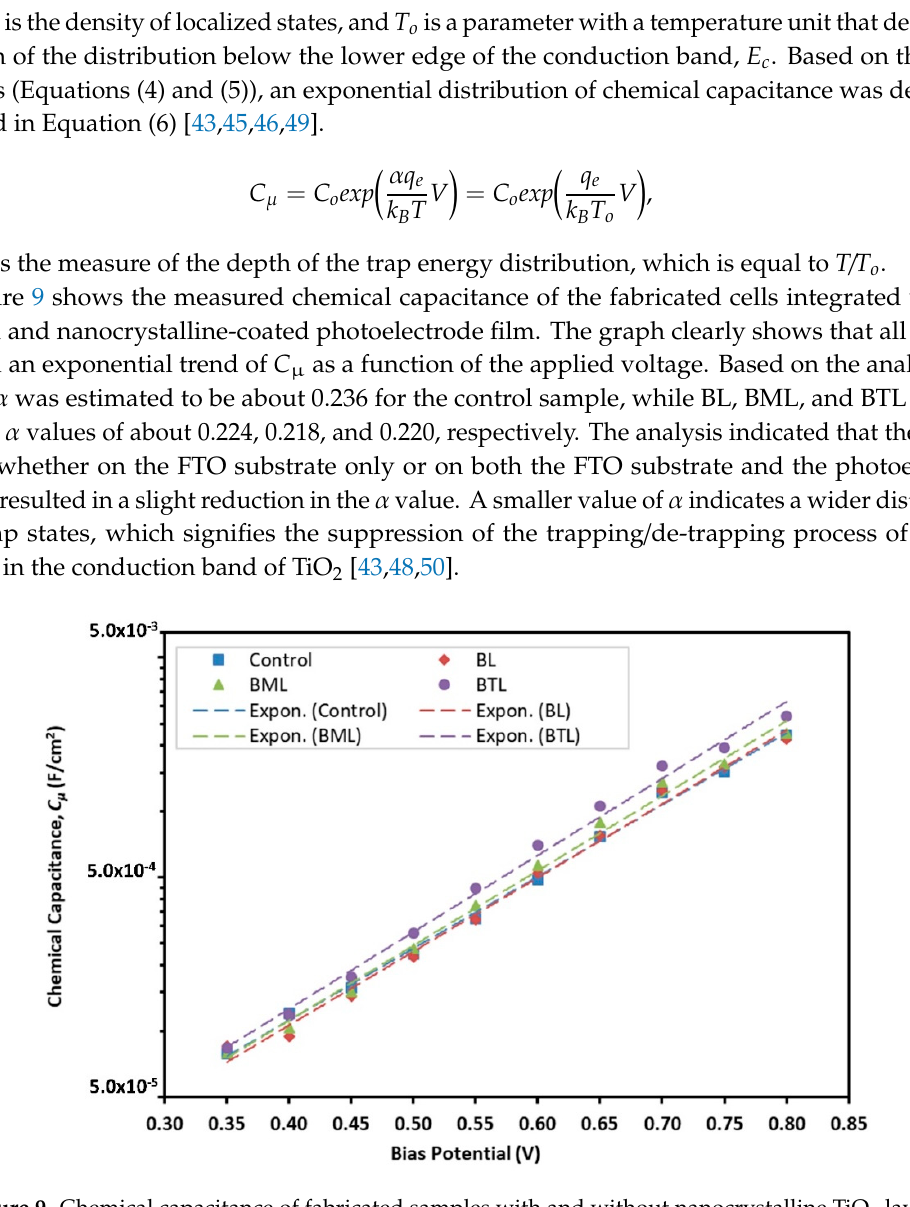
Figure 9. Chemical capacitance of fabricated samples with and without nanocrystalline TiO 2 layer.